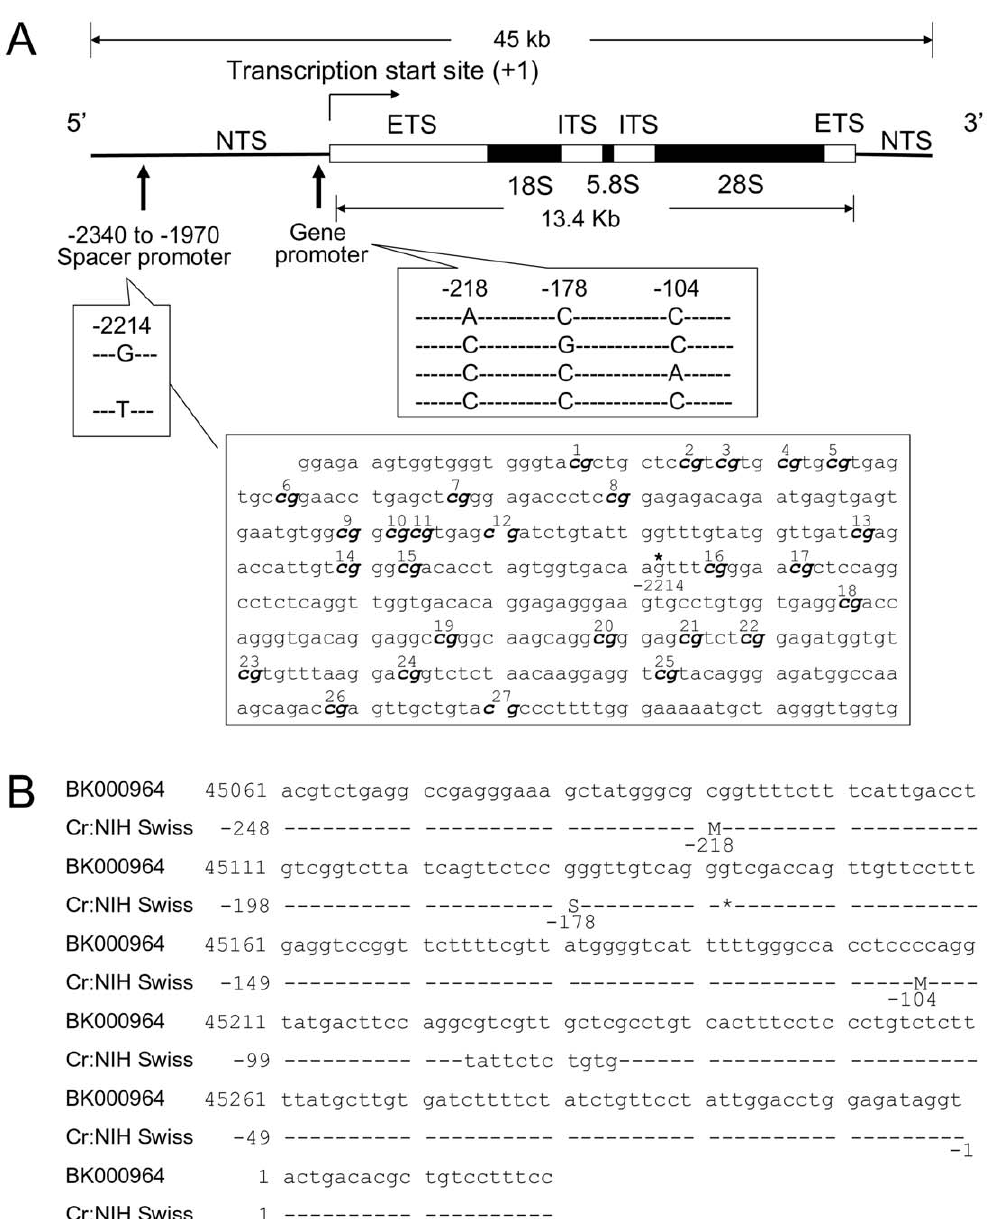
Figure 1. The mouse rDNA gene. (A) Locations of CpG sites and G/T SNP in a spacer promoter region ( 2 2340 to 2 1946) and 4 sequence variants (haplotypes) with unique SNP combinations in the gene promoter. *G/T SNP; NTS: nontranscribed spacer; ETS: external transcribed spacer; ITS: internal transcribed spacer. (B) Sequence alignment of a Cr:NIH Swiss rDNA gene promoter region, upstream of the transcription start site 1, to the GenBank BK000964. The Cr:NIH Swiss sequence was obtained by cloning and dideoxy sequencing (M: A/C SNP; S: C/G SNP; *deletion).